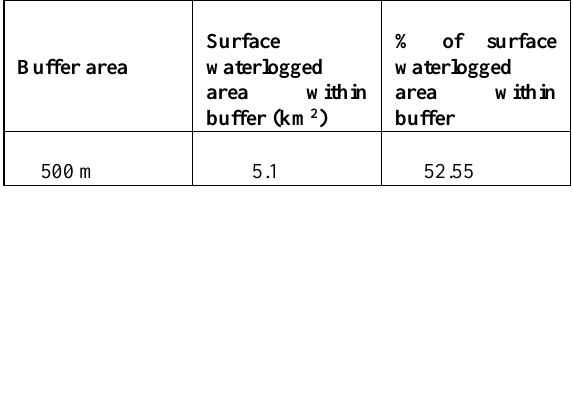
Fig 10: Surface waterlogged areas map (December, 2016)